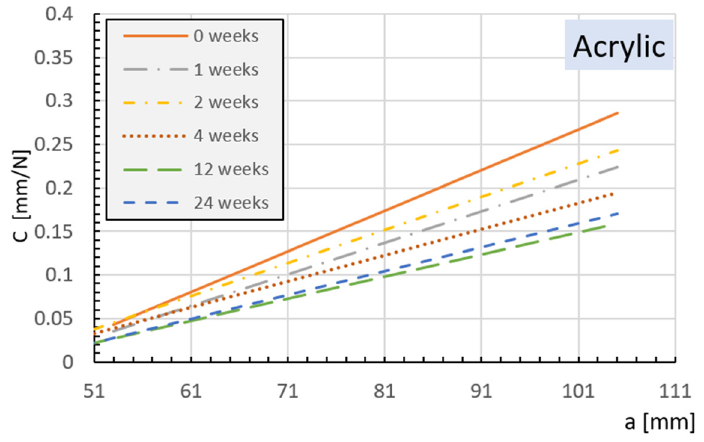
Figure 12. Trend lines in flexibility growth phase versus delamination length for acrylic adhesive.